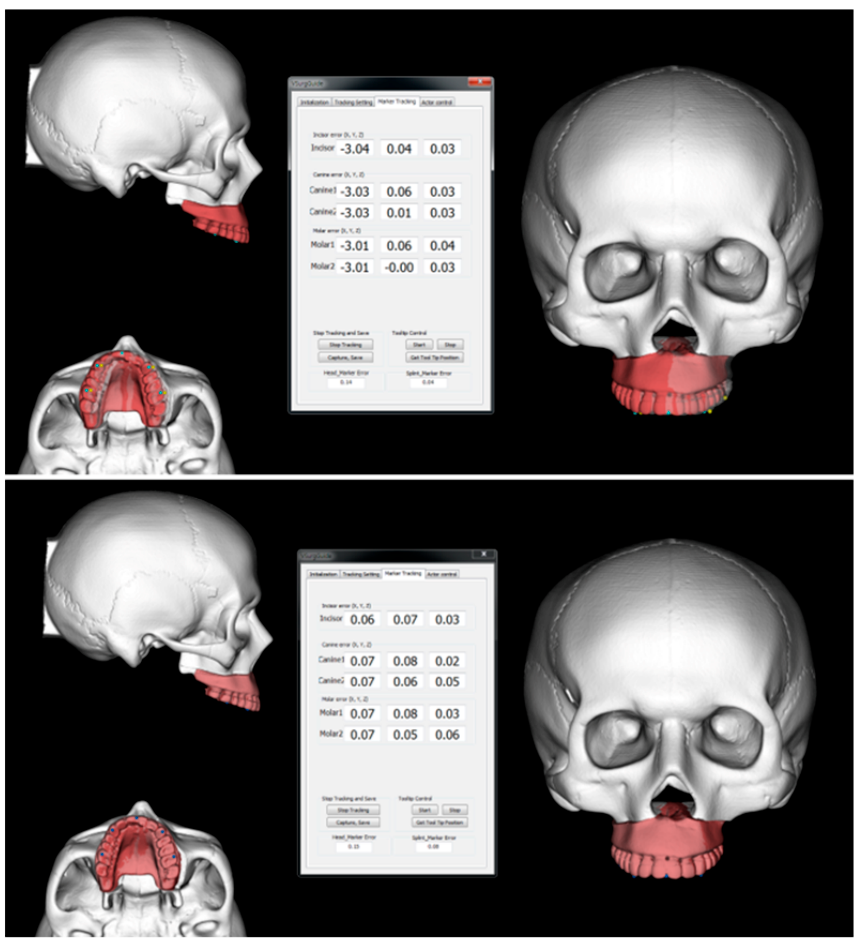
Figure 2. Image-guided navigation using the optical tracking system. The target and actual positions of the maxilla is visualized in real time and the discrepancy between two positions at the five dental landmarks is also